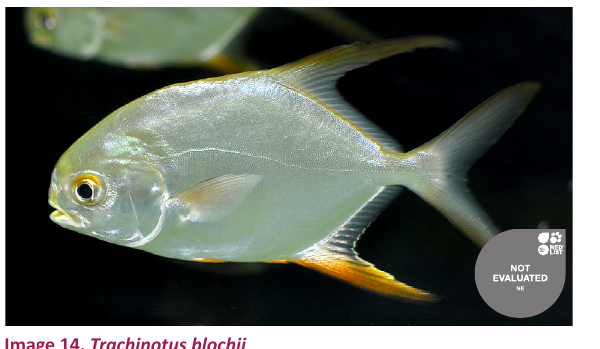
Image 14. Trachinotus blochii